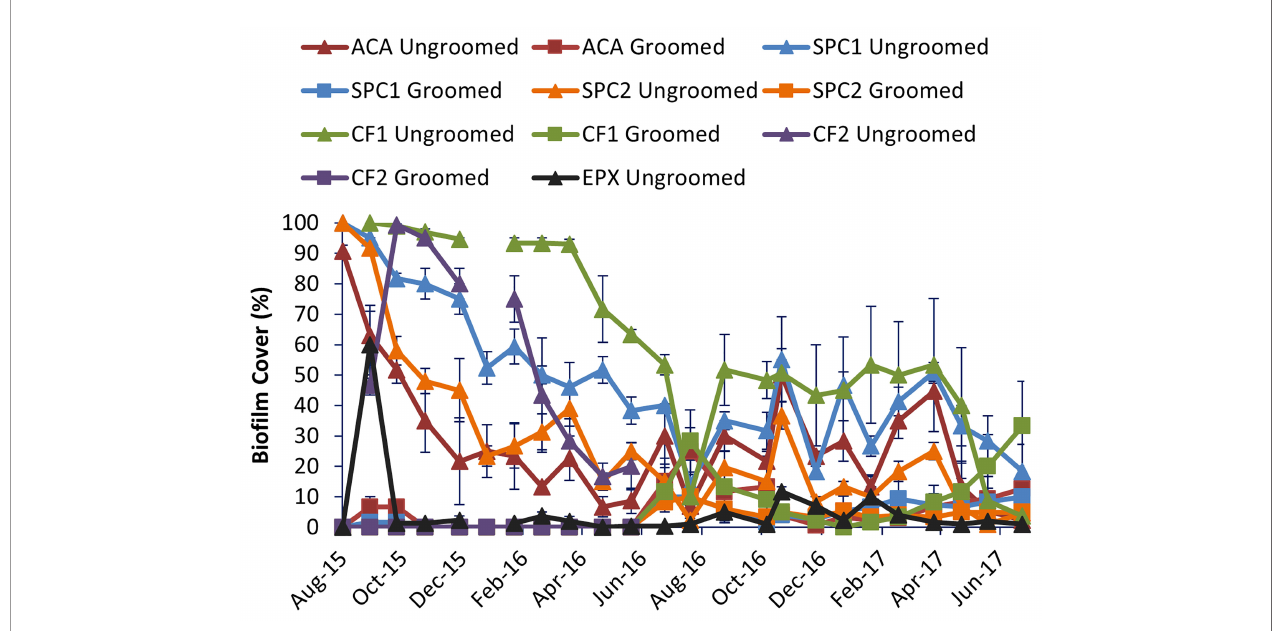
FIGURE 2 | Comparison of bio fi lm cover among the different coatings. Error bars represent one standard error, n = 3 replicate panels for each coating and grooming